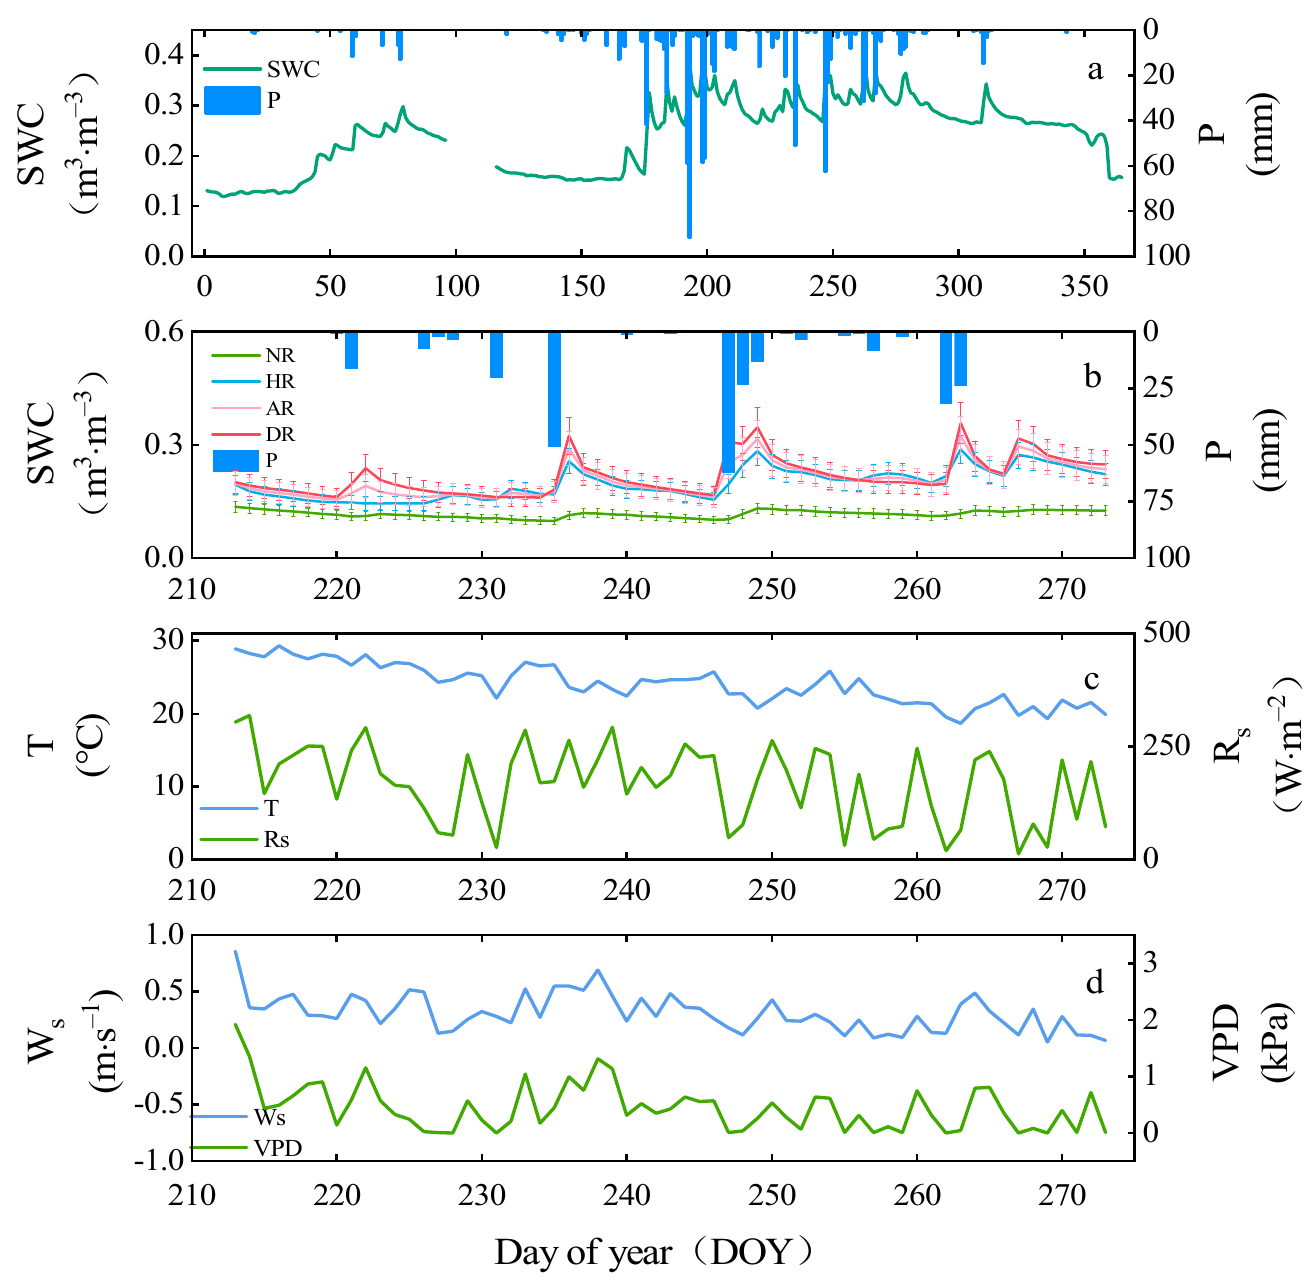
August 1 and the minimum value on September 26, with an average value of 0.31 m · s − 1 . The VPD varied from 0 to 1.92 kPa, with an average of 0.44 kPa.